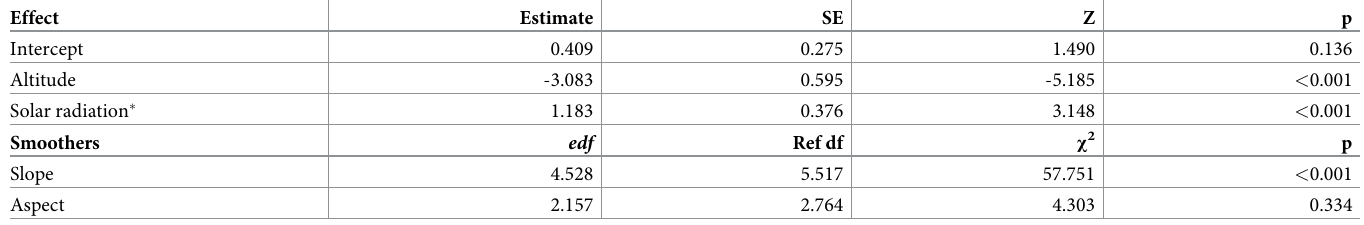
Table 4. Parameter estimates of the best-supported GAM model explaining variation in colony presence/absence. Effective degrees of freedom ( edf ) is a measure of wiggliness of a smoother (a linear relationship on the logit scale has edf of 1).